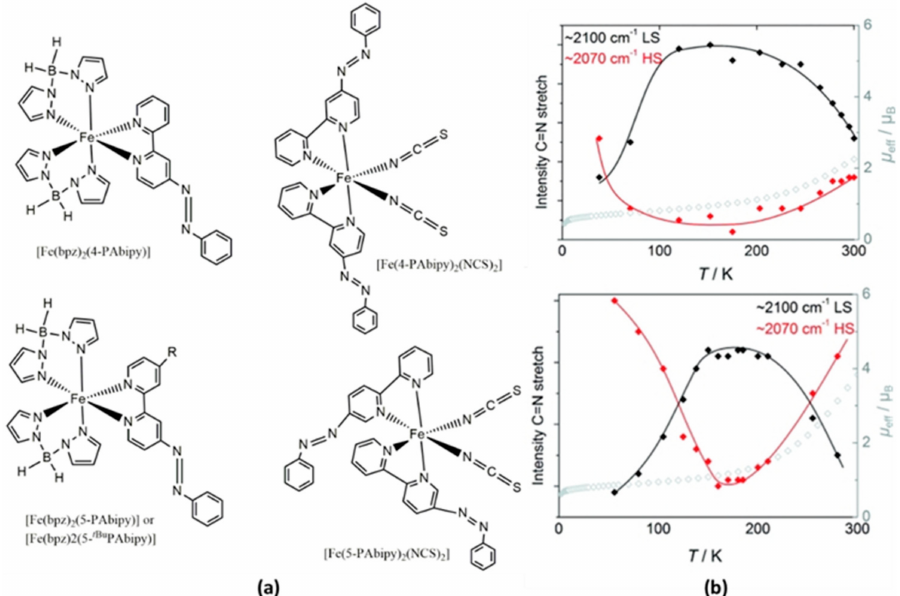
Figure 6. ( a ) Structural drawing of the iron spin-crossover complexes with phenylazo-functionalized 2,2 (cid:48) - bipyridine ligands (PAbipy); [Fe(bpz) 2 (4-PAbipy)], [Fe(bpz) 2 (5-PAbipy)], [Fe(bpz) 2 (5- t Bu PAbipy)], [Fe(4-PAbipy) 2 (NCS) 2 ], [Fe(5-PAbipy) 2 (NCS) 2 ]. ( b ) Intensity of the C=N stretching vibration of the LS (black) and HS (red) stares as extracted from the resonance Raman spectra at various temperatures for complexes [Fe(4-PAbipy) 2 (NCS) 2 ] (up) and [Fe(5-PAbipy) 2 (NCS) 2 ] (down). The gray circles correspond to the relative susceptibility data. ( b ) is reprinted with permission from ref. [83], copyright 2016,